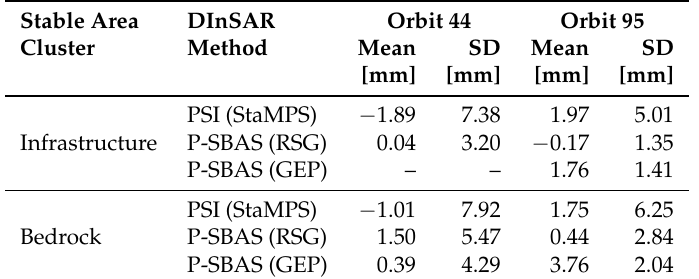
Table 2. Annual DInSAR (pseudo-)deformation values in line-of sight (LOS) for stable area clusters. mean values refer to the slope of the linear trend within one year (365.25 days), obtained from a linear regression of deformation rates on the date. SD denotes the corresponding standard deviation of the residuals. The infrastructure cluster comprises polygons of five horizontal artificial areas (building flat roofs and parking areas). The bedrock cluster comprises polygons of 17 bedrock areas (Figure 1C). Abbreviations: StaMPS, Stanford Method for Persistent Scatterers; P-SBAS, Parallel Small Baseline